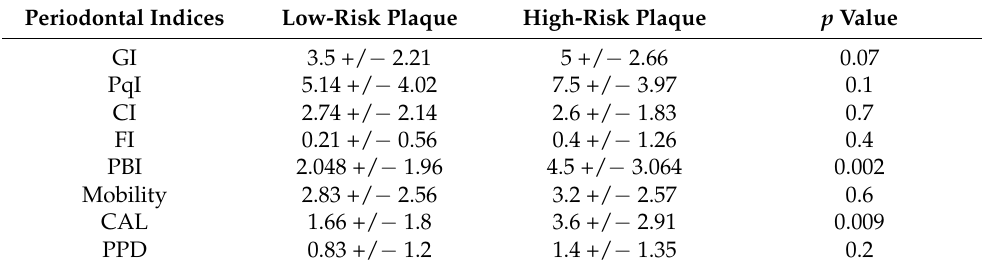
Table 3. Periodontal indices in low-risk plaque vs. high-risk plaque.